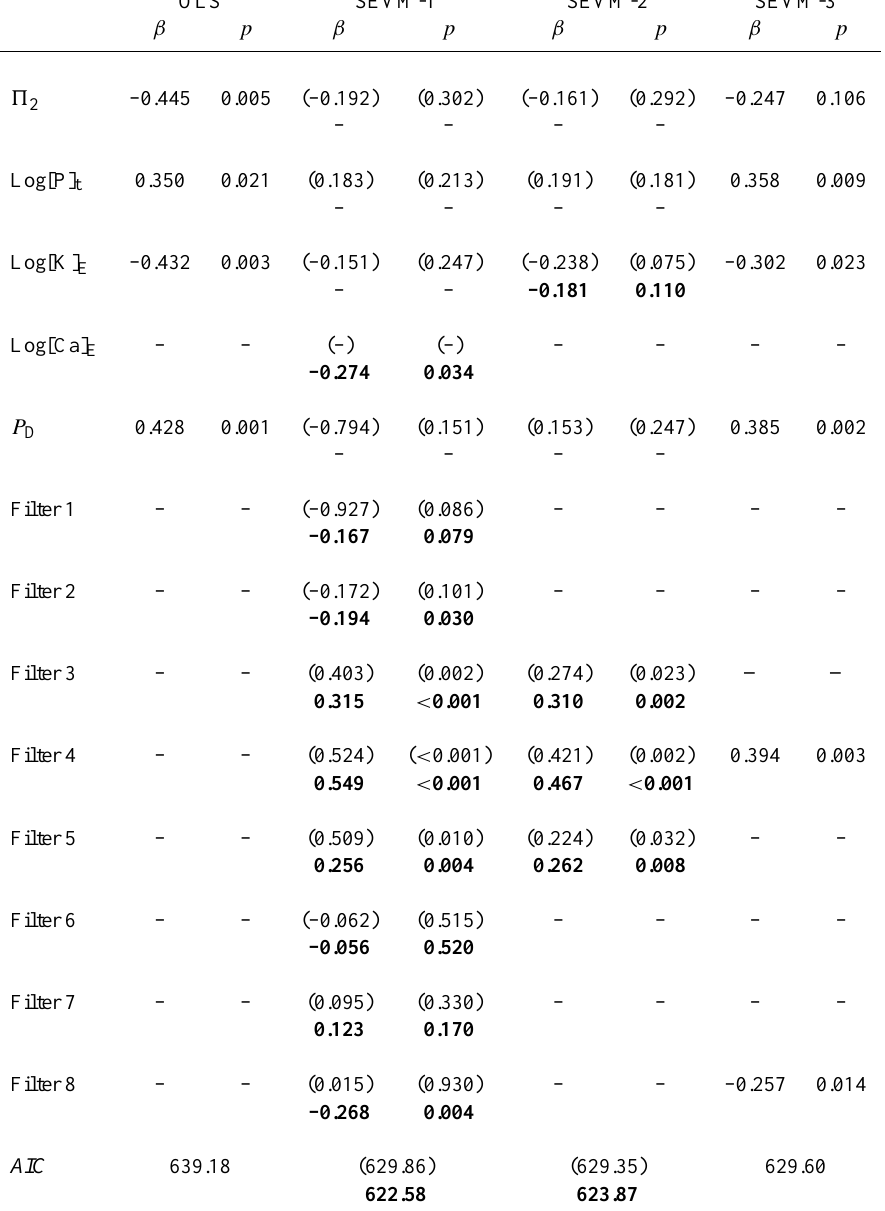
Table 8. Lowest AIC model fits for the prediction of stand biomass with and without the use of spatial filters. For each variable, the upper line gives first the standardised coefficients ( β ) and their level of significance ( p ) from the best OLS model fit followed by the results (in brackets) when the same OLS model is applied with the preselected spatial filter included. Also shown in bold (second line) for each variable are the values of β and p obtained for the lowest AIC model fit with the spatial filters included. Variables not included in any given model fit are denoted with a “–”. Variables: 5 2 ; Quesada et al (2010)’s second index of soil physical properties: [P] t ; total soil phosphorus: [K] E ; exchangeable soil potassium: [Ca] E ; exchangeable soil calcium: P D ; dry season precipitation. The numbering of the spatial filters is